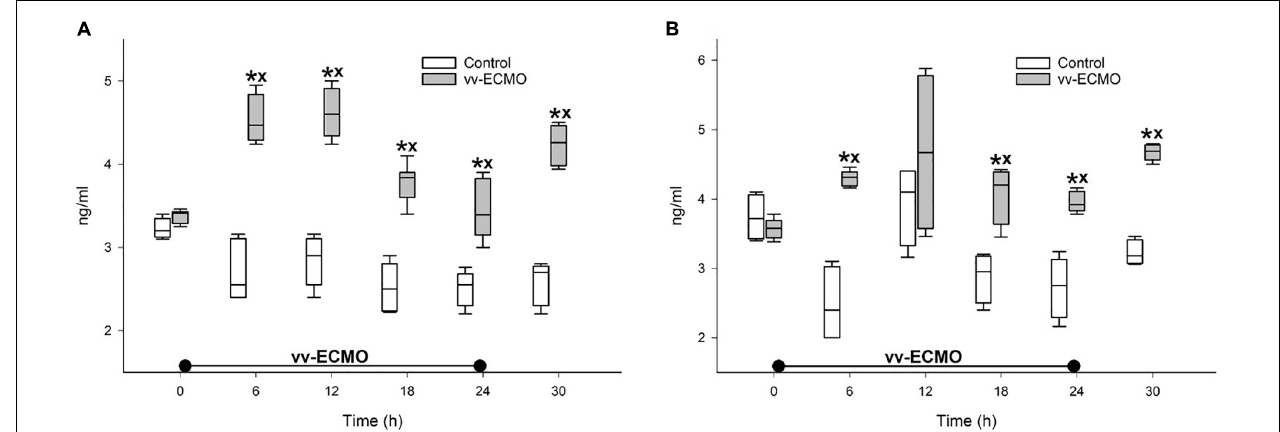
FIGURE 5 | Changes in the neutrophil gelatinase-associated lipocalin levels in the urine (A) and plasma (B) in the control group (empty box) and vv-ECMO group (gray box). The plots demonstrate the median (horizontal line in the box), the 25th and 75th percentiles, and the range of data (whiskers). * P < 0.05 for groups vs. baseline values (Friedman and Dunn tests), x P < 0.05 for the vv-ECMO vs. control group values (Mann–Whitney test).